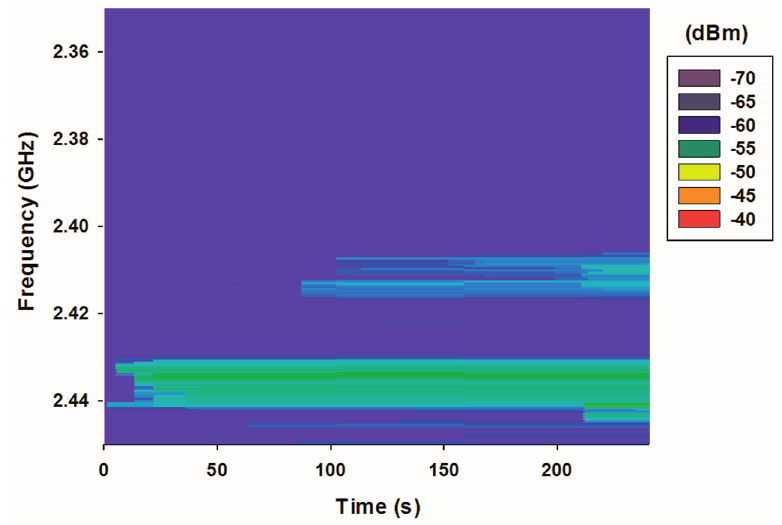
Figure 15. Measured spectrogram without operating WSN nodes.